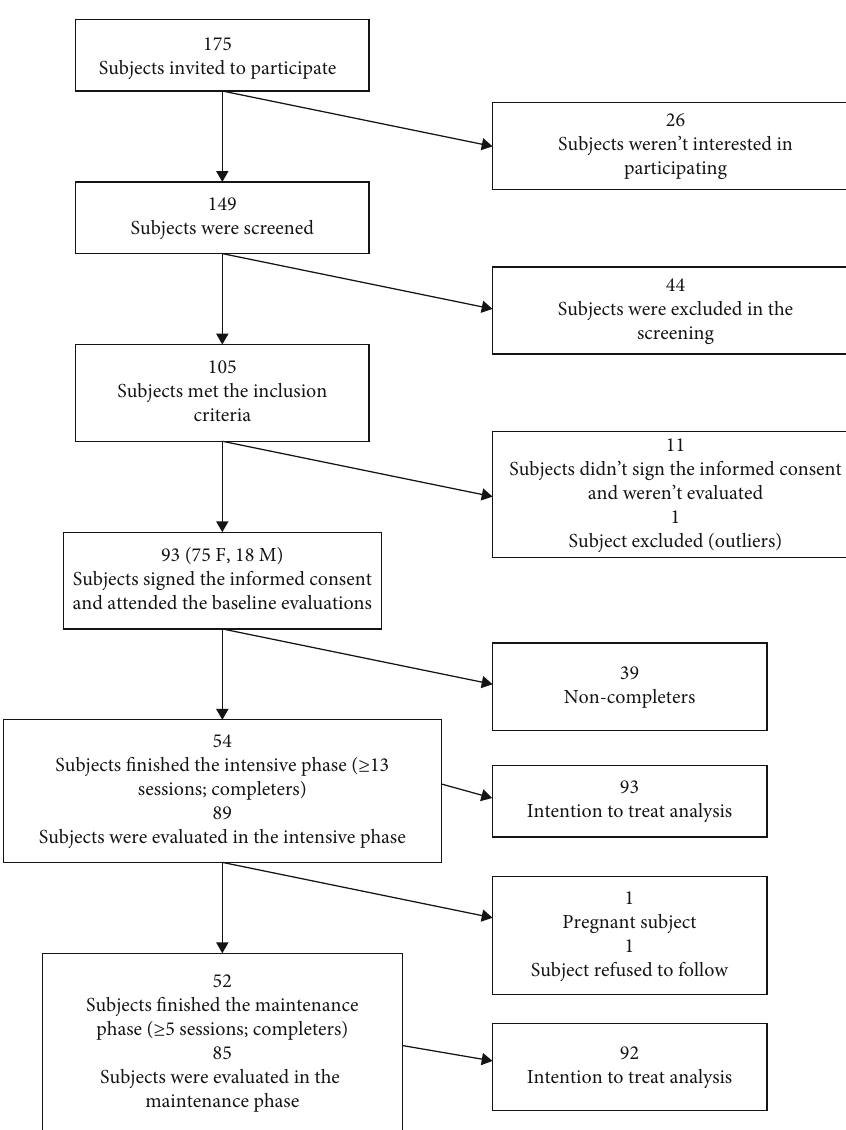
Figure 1: Recruitment and participation of subjects in the intensive (6 months) and maintenance phase (12